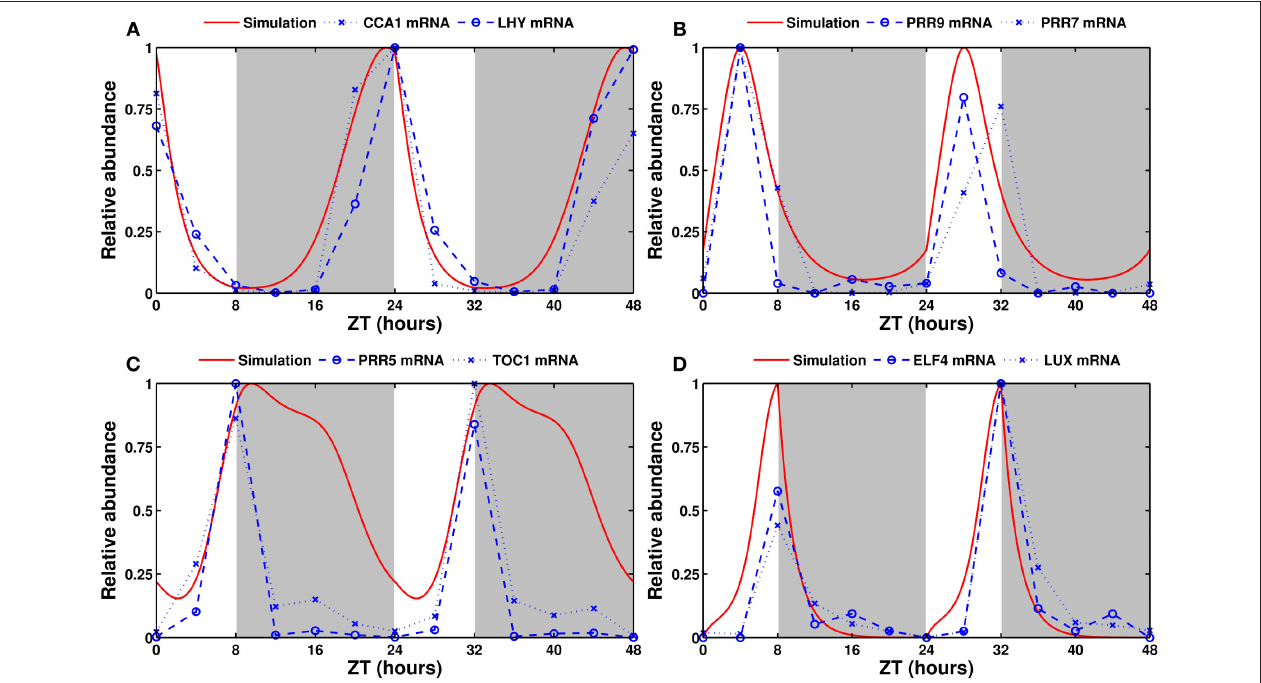
FIGURE 2 | Experimental and simulated expression profiles in short days (8L:16D). Experimentally measured (in blue) and simulated (in red) mRNA levels of (A) CCA1 and LHY , (B) PRR9 and PRR7 , (C) PRR5 and TOC1 , and (D) ELF4 and LUX . All values are normalized to their respective maximum. The experimental data was obtained by qRT-PCR (see Section